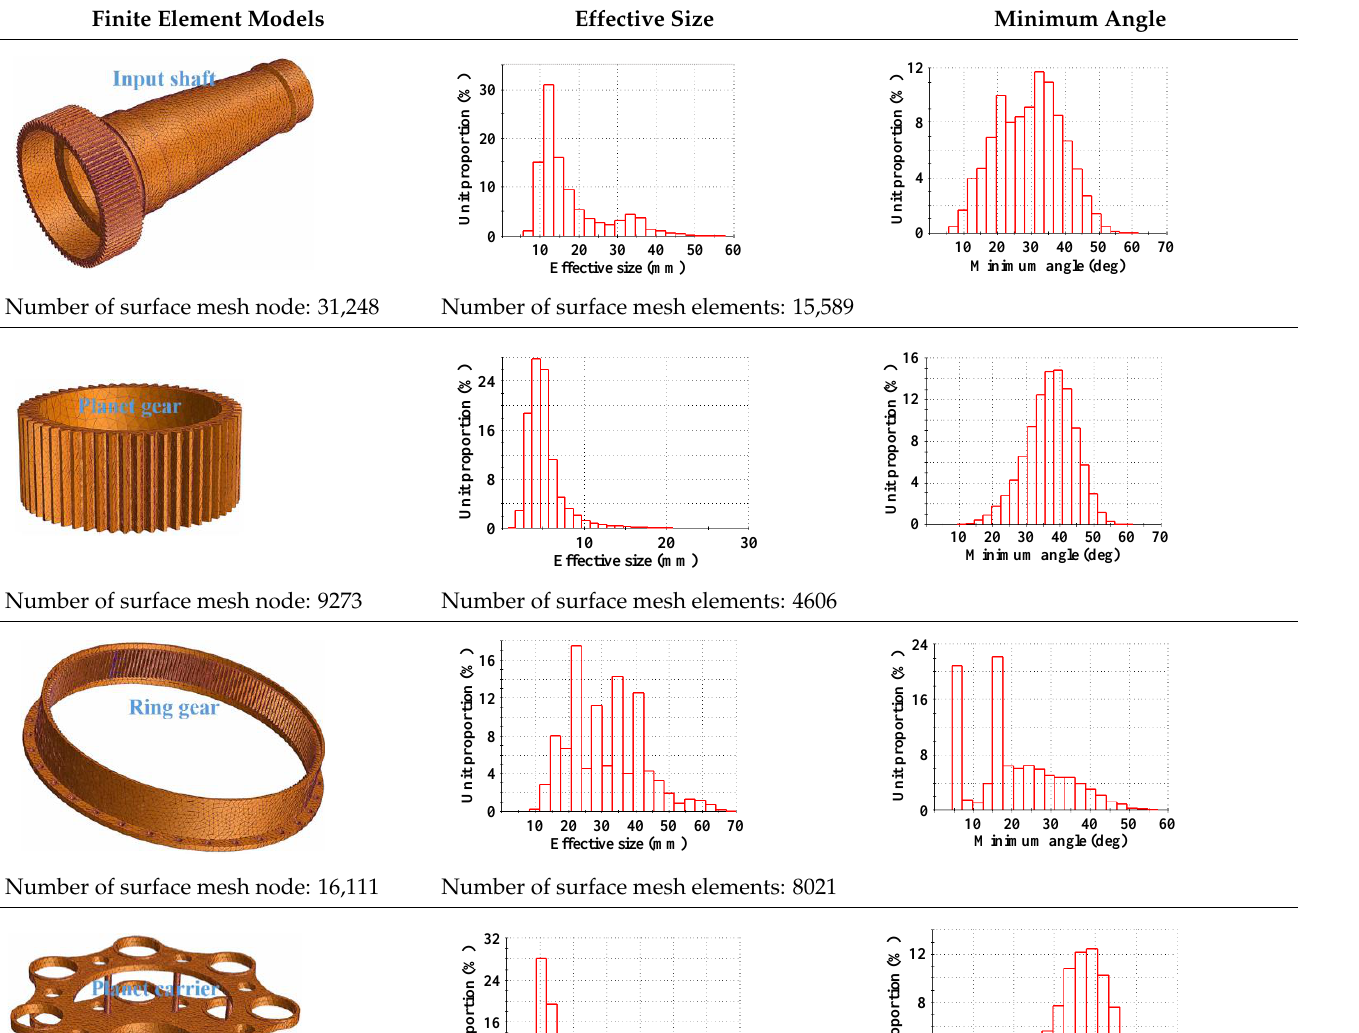
Table 3. Finite element model and mesh quality parameter.